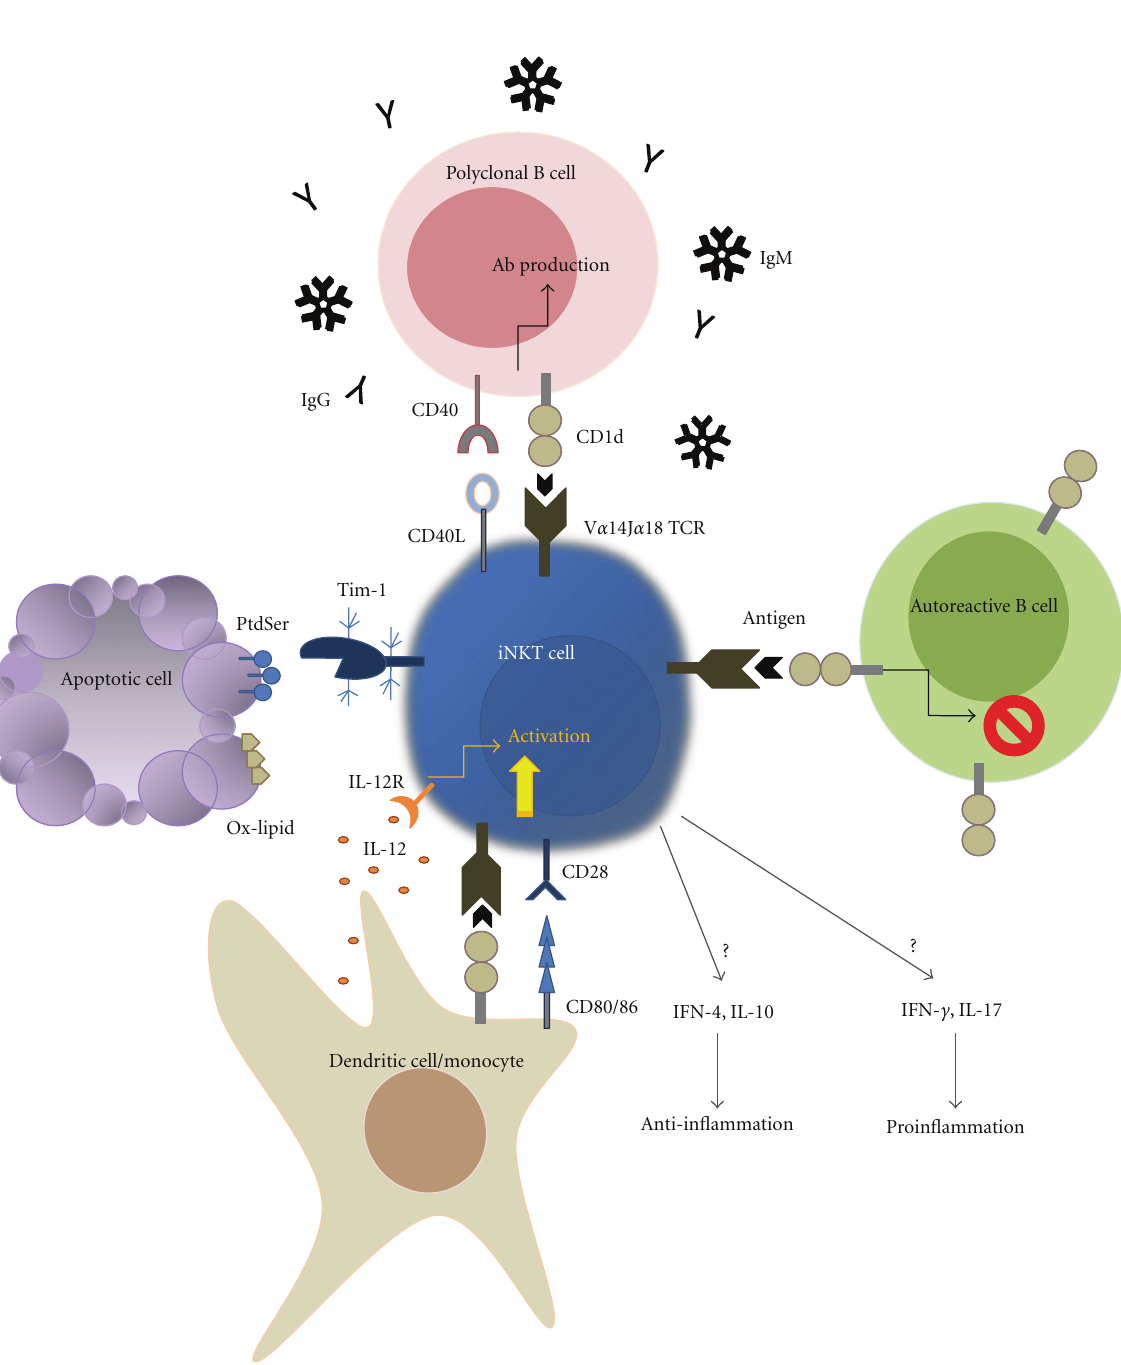
Figure 1: The function of iNKT cells in murine lupus models. iNKT cells in the mouse that express invariant TCR, V α 14J α 18, are CD1d- restricted T lymphocytes. The antigens presented by CD1d can be microbial components, endogenous antigen, iGb3, or oxidized lipid (Ox- lipid) derivatives from apoptotic cells. DCs and monocytes are potent APCs that activate iNKT cells both directly through TCR engagement and indirectly through IL-12. Immediately upon activation, iNKT cells release Th1-, Th2-, and T17-related cytokines, depending on the antigen presented and/or the characteristics of the APCs. The proinflammatory cytokines, IFN- γ and IL-17, lead predominantly to SLE exacerbation. iNKT cells can sense apoptotic blebs through Tim-1, which recognizes phosphatidylserine (PtdSer) exposed on the outer leaflet membrane, and can mediate immune suppression (see text). By contrast, iNKT cells activate B cells and thus upregulate total IgG and IgM levels in a CD1d-dependent manner, but iNKT cells can also inhibit the activation of autoreactive B cells. CD1d expression levels suggest that iNKT cells are capable of discriminating self- from nonself-reactive B